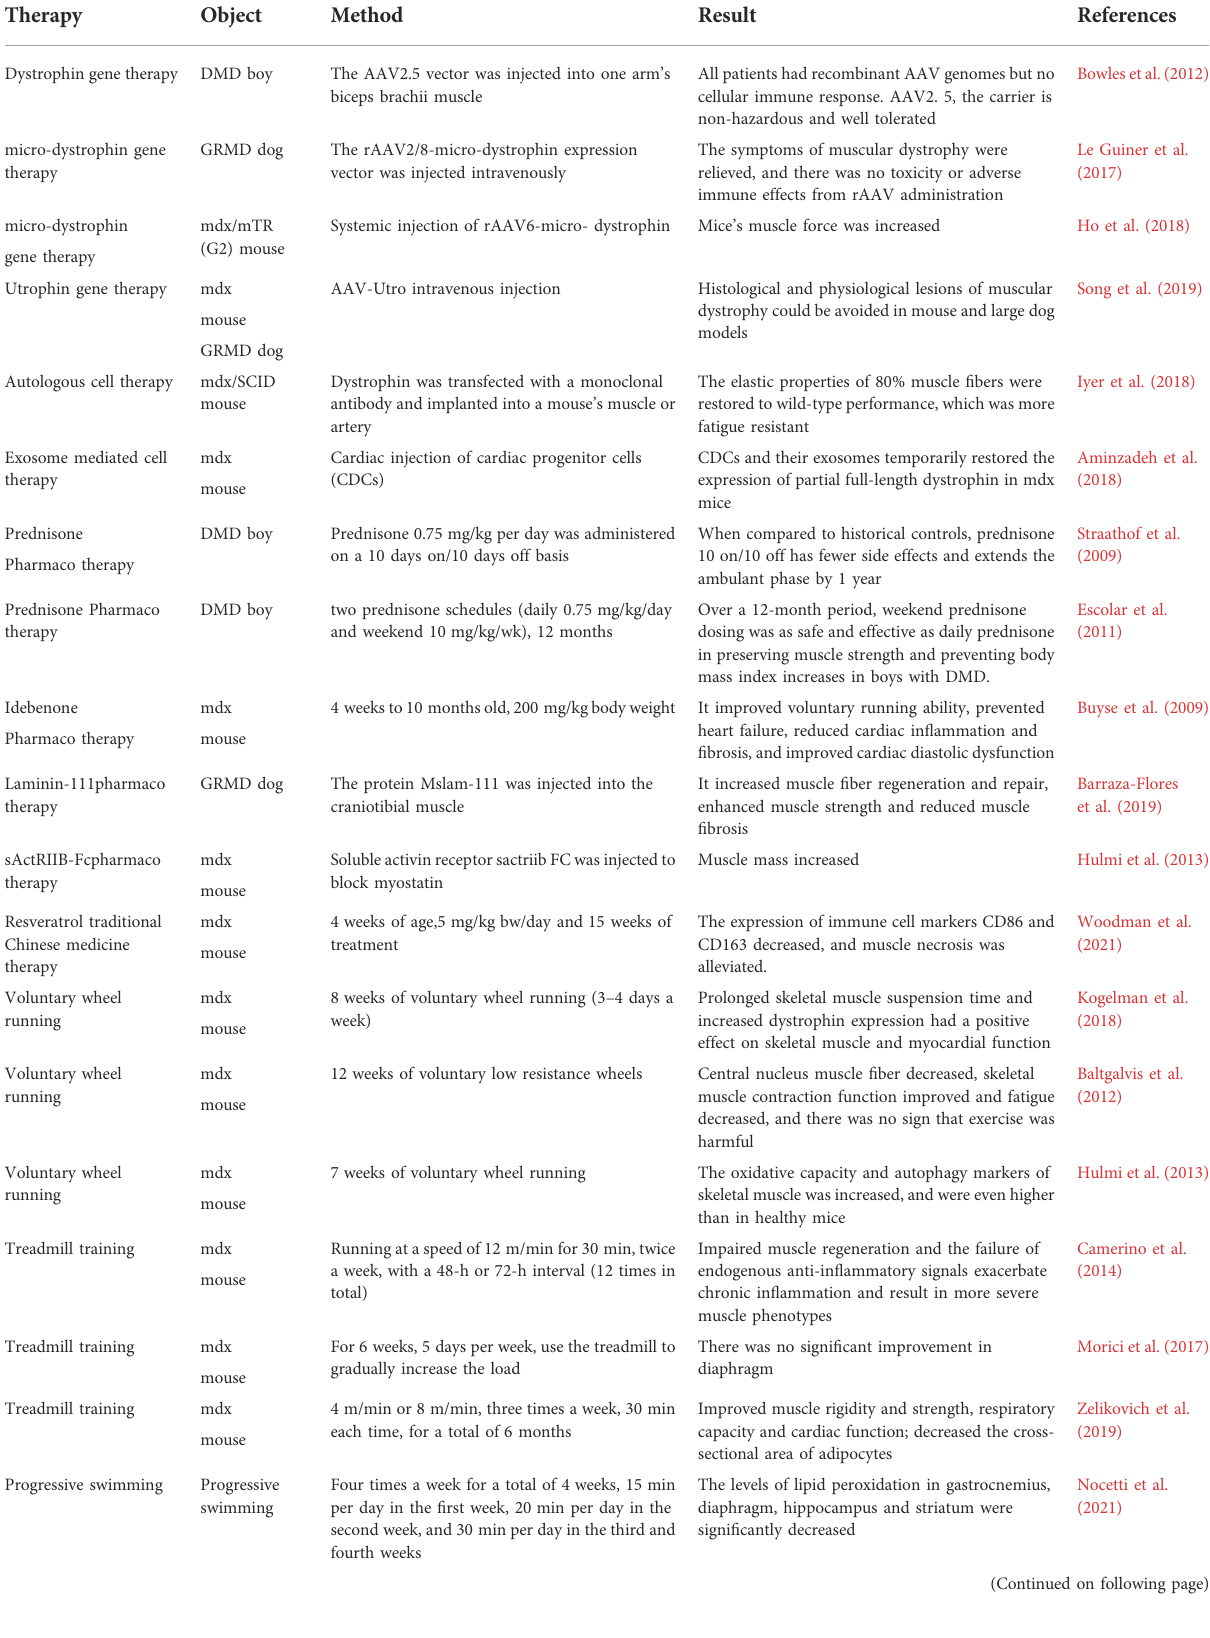
TABLE 2 Ef fi cacy comparison of major DMD